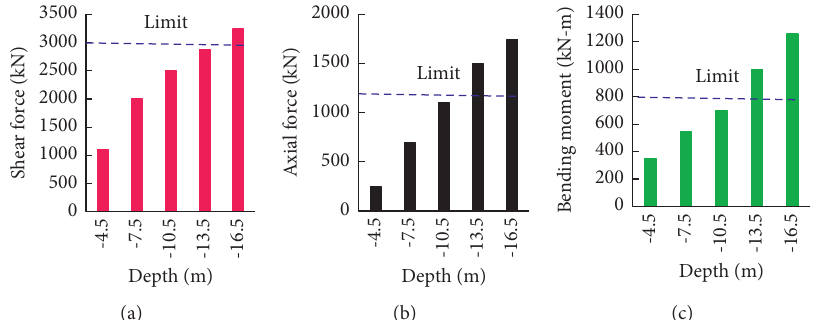
Figure 7: Influence of the application of steel bracing support alone on wall (a) shear force, (b) axial force, and (c) bending moment.